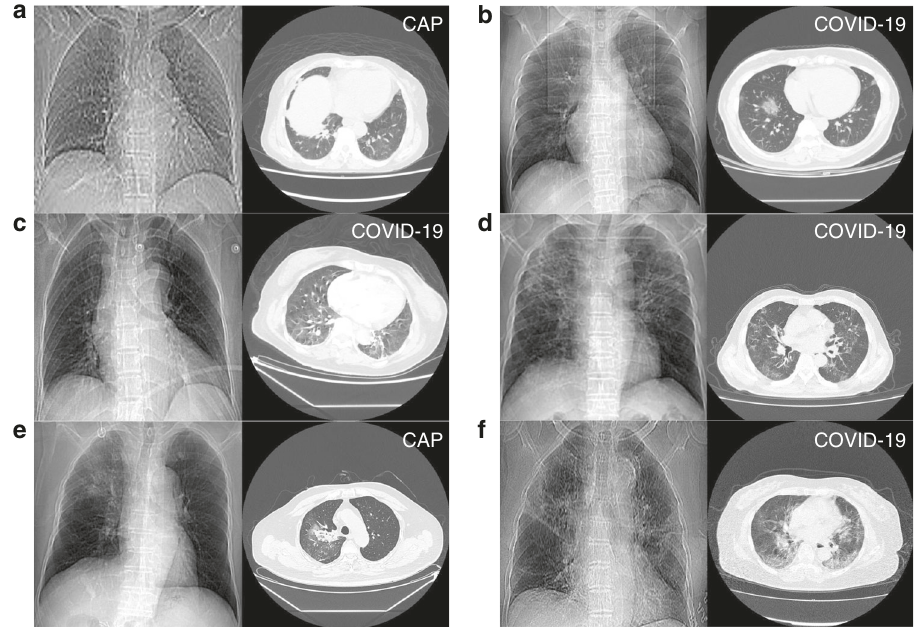
Fig. 6 Representative diagnosis results of CT-based AI system and CXR-based AI system. a An example that both CXR and CT were wrong. b An example that both CXR and CT were correct. c An example that CXR was correct, CT was wrong, and fusion result was wrong. d An example that CT was correct, CXR was wrong, and fusion result was correct. e An example that CXR was correct, CT was wrong, and fusion was correct. f A case that CXR was wrong, CT was correct, and fusion was wrong. Note: the true classes were annotated at the upper right of every